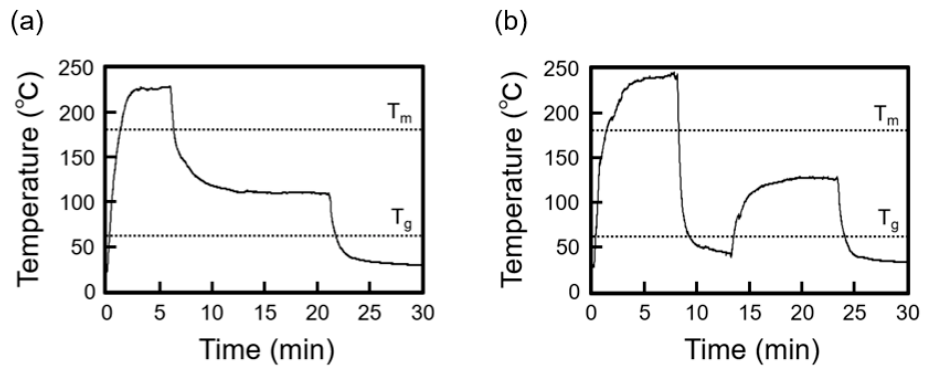
Figure 3. Temperature during the micromolding process. ( a ) After PLLA melting, it was maintained at crystallization temperature (120–130 °C) and then cooled to room temperature (micromolding process (i)). ( b ) After PLLA melting, it was rapidly cooled from >200 °C/min to below T g and then heated to crystallization temperature (micromolding process (ii)).